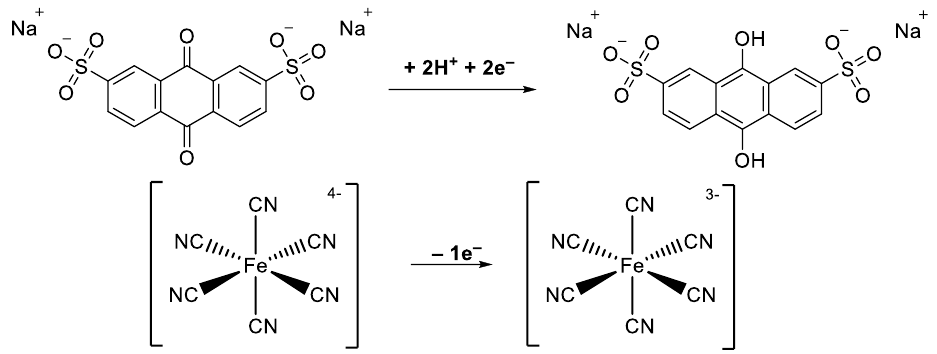
Scheme 1. Electrochemical reactions of redox – active materials used in our